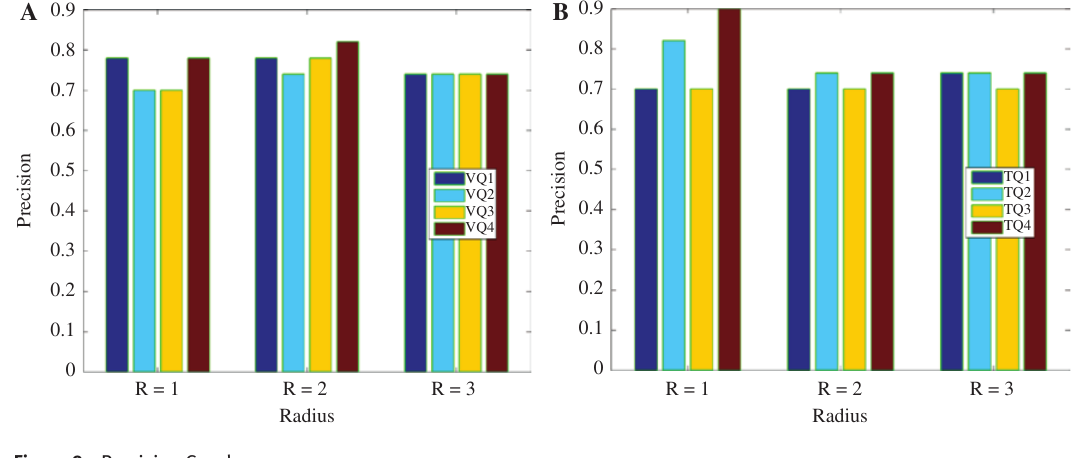
Figure 9: Precision Graph. (A) Video queries. (B) Text queries.